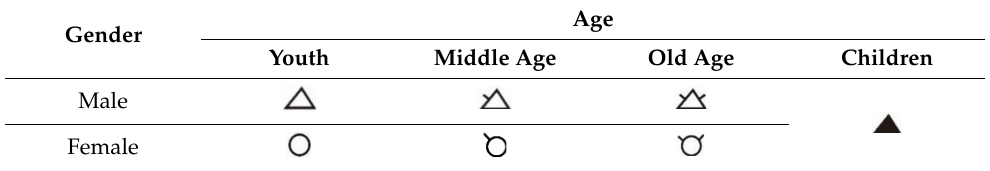
Table 2. The mark diagrams of user demographic characteristics.